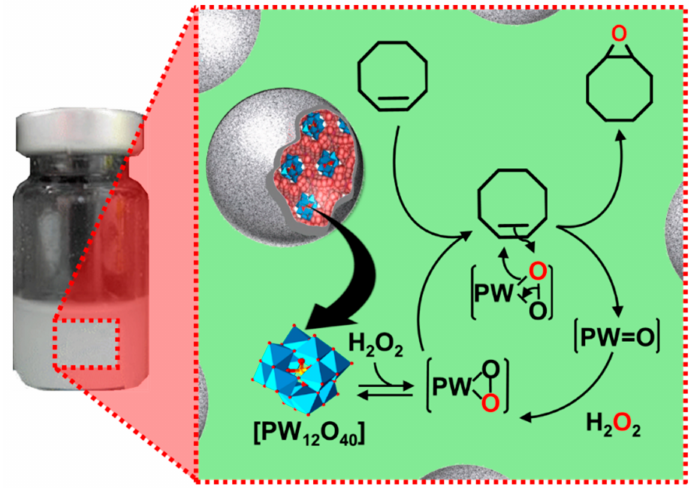
Figure 57. The mechanism of olefin epoxidation inside a colloidal solution suspension (sol)